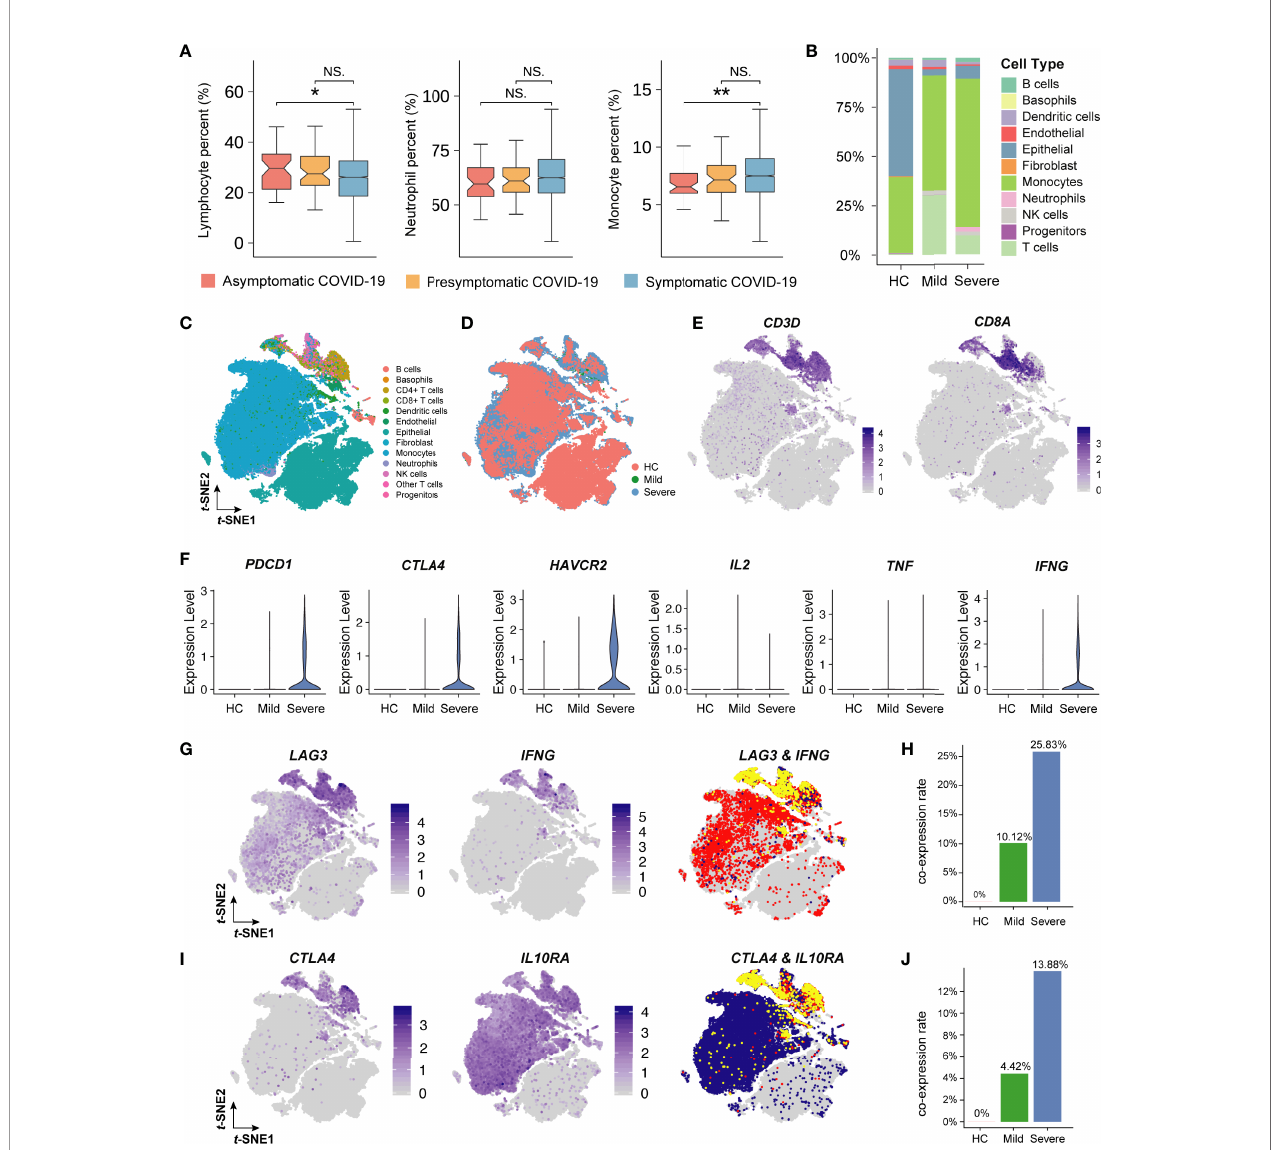
FIGURE 5 | Single-cell analysis of immune cells in COVID-19 patients. (A) The box plot describes the proportion of lymphocytes, neutrophil, and monocyte. The vertical axis indicates the values of laboratory indicators. The P -value was calculated using Wilcoxon ’ s rank-sum test and shown at the top of each panel. Boxplots represent the 25th and 75th percentiles, with midlines indicating the median values. ** represents P -value < 0.01. * represents P -value < 0.05. NS. represents P - value > 0.05. (B) The histogram shows the proportion of 11 main cell types (including 13 clusters, 3 T cell subpopulations are merged as one) in healthy people (HC), mild patients, and severe patients. The vertical axis indicates the fraction of the cell type. Each color represents a cell type. (C) The t-distributed stochastic neighbor embedding (t-SNE) plot of 13 cell clusters for seventeen patients with or without COVID-19. (D) The t-SNE plot of 13 cell clusters colored by patient type. Red, green, and blue represents the HC, mild, and severe group, respectively. (E) The t-SNE plot of CD+8 T cells colored by cell-type-speci fi c markers. The shade of the color represents the level of gene expression. (F) Violin plots of the inhibitory-receptors and cytokines ’ gene expression. The vertical axis indicates the level of gene expression. (G) and (I) The t-SNE plot of inhibitory-receptor coexpression patterns. Yellow represents the cells expressing two genes at the same time. (H) and (J) The bar plot shows the proportion of inhibitory-receptor coexpression patterns. The vertical axis indicates the rate of coexpression